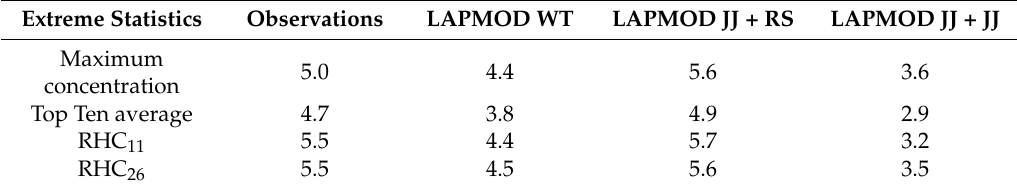
Table 3. Extreme statistics for the Indianapolis best-quality observations ( µ g m − 3